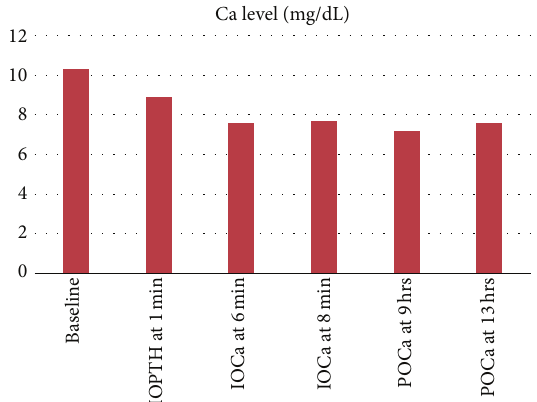
Figure 6: Perioperative calcium monitoring, IOCa (intraoperative calcium), POCa (postoperative calcium), and Mg/dL (milligrams/